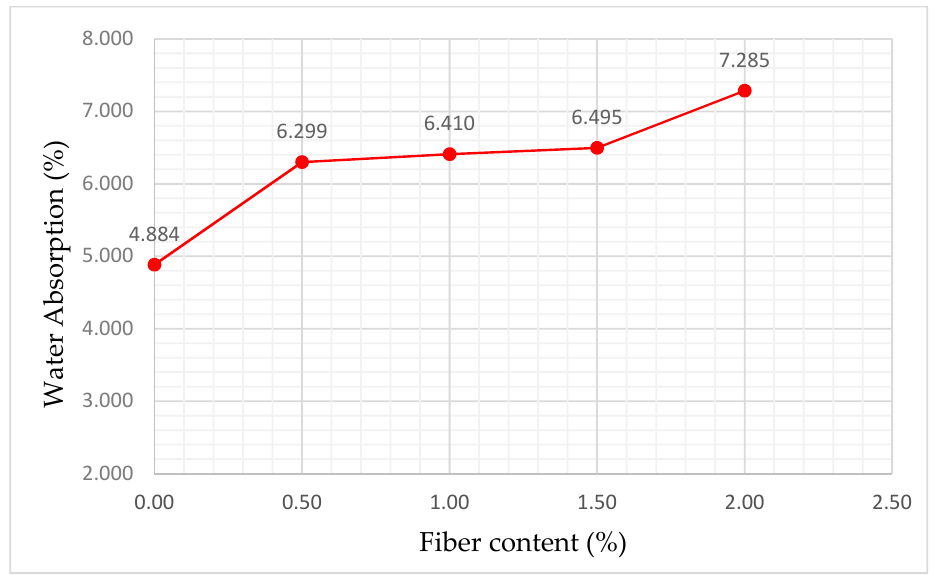
Figure 4. Effect of sisal fibers on the water absorption of concrete.